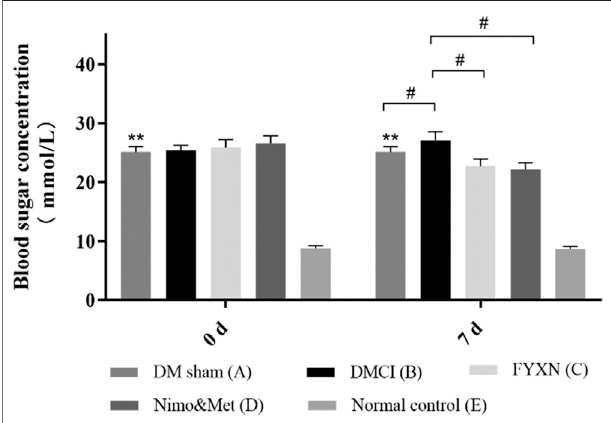
FIGURE 2 | FYXN decreased blood glucose in a rat DMCI model (mean ± SD, mmol/L), * p < 0.05, ** p < 0.01 compared with NC group; # p < 0.05 compared with DMCI group.